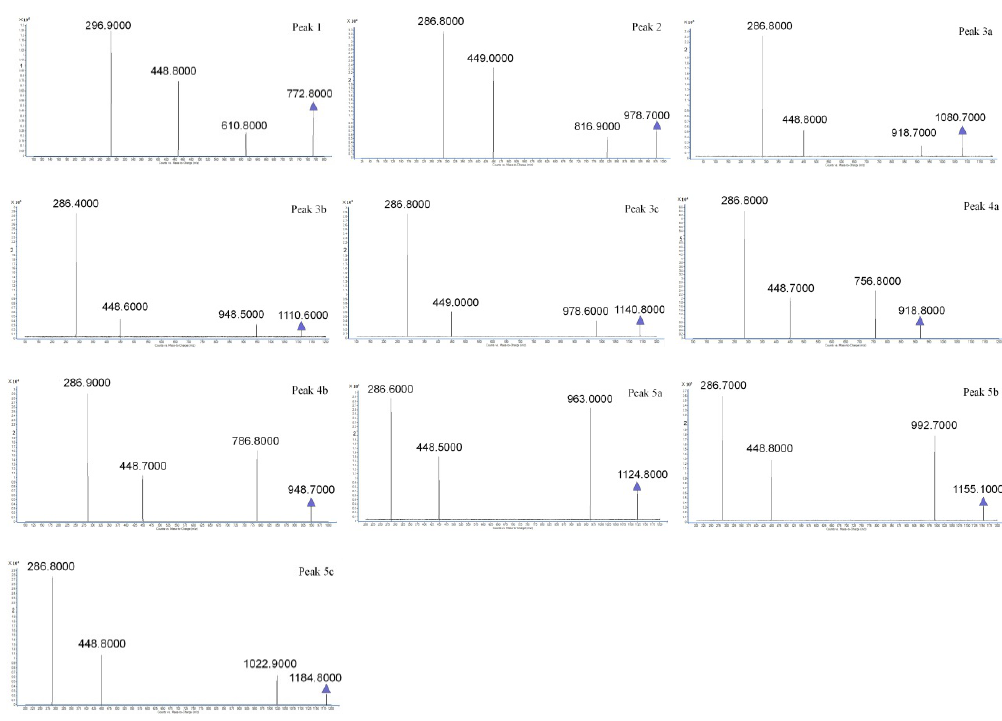
Figure 5. The ESI-MS2 spectra of ten monomeric anthocyanins in red cabbage. The MS was operated in positive mode. “